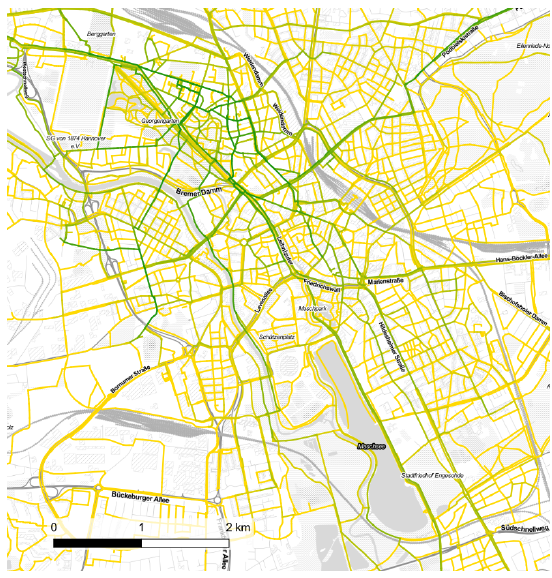
Figure 2. Overview of the city center of Hannover. The street segments are colored by the number of visits from yellow (single) to dark green (about 100). Basemap from Stamen